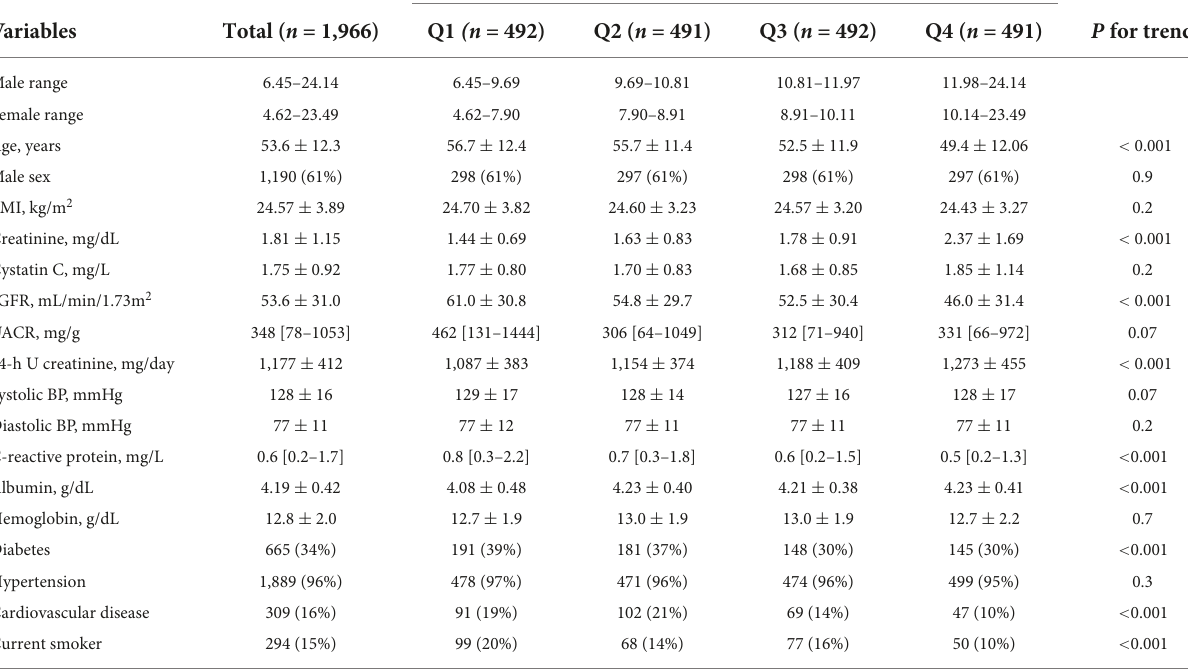
TABLE 1 Baseline characteristics according to serum Cr/CysC ratio quartiles in 1,966 adults with chronic kidney disease. Quartile of creatinine/Cystatin C ratio